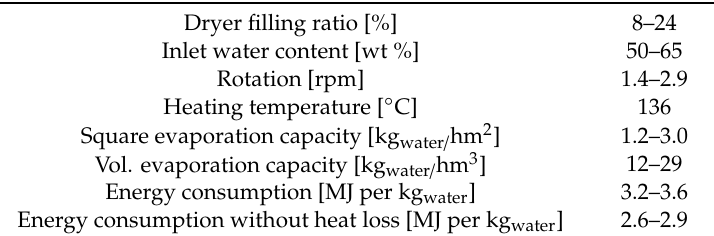
Table 3. Operating parameters during experiments.